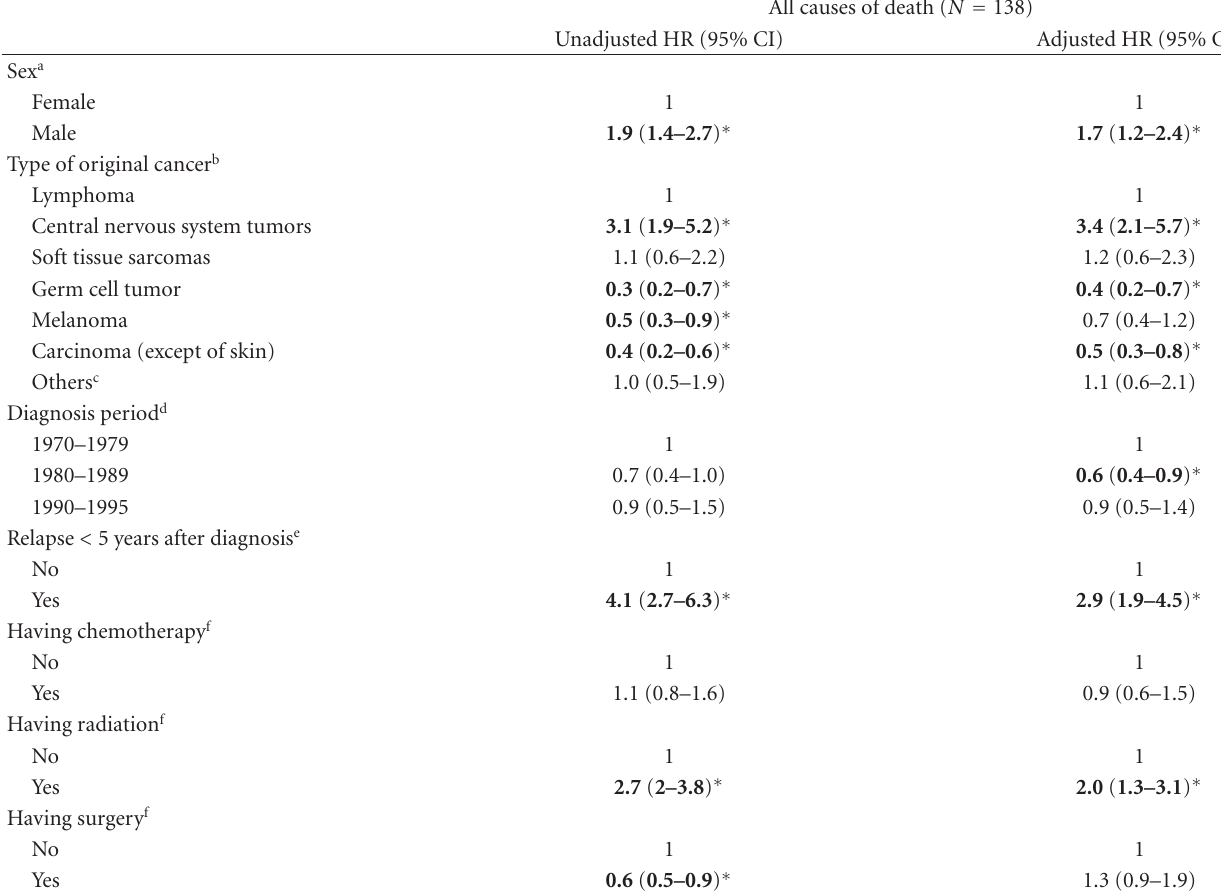
Table 4: Hazard ratio of mortality for all causes of